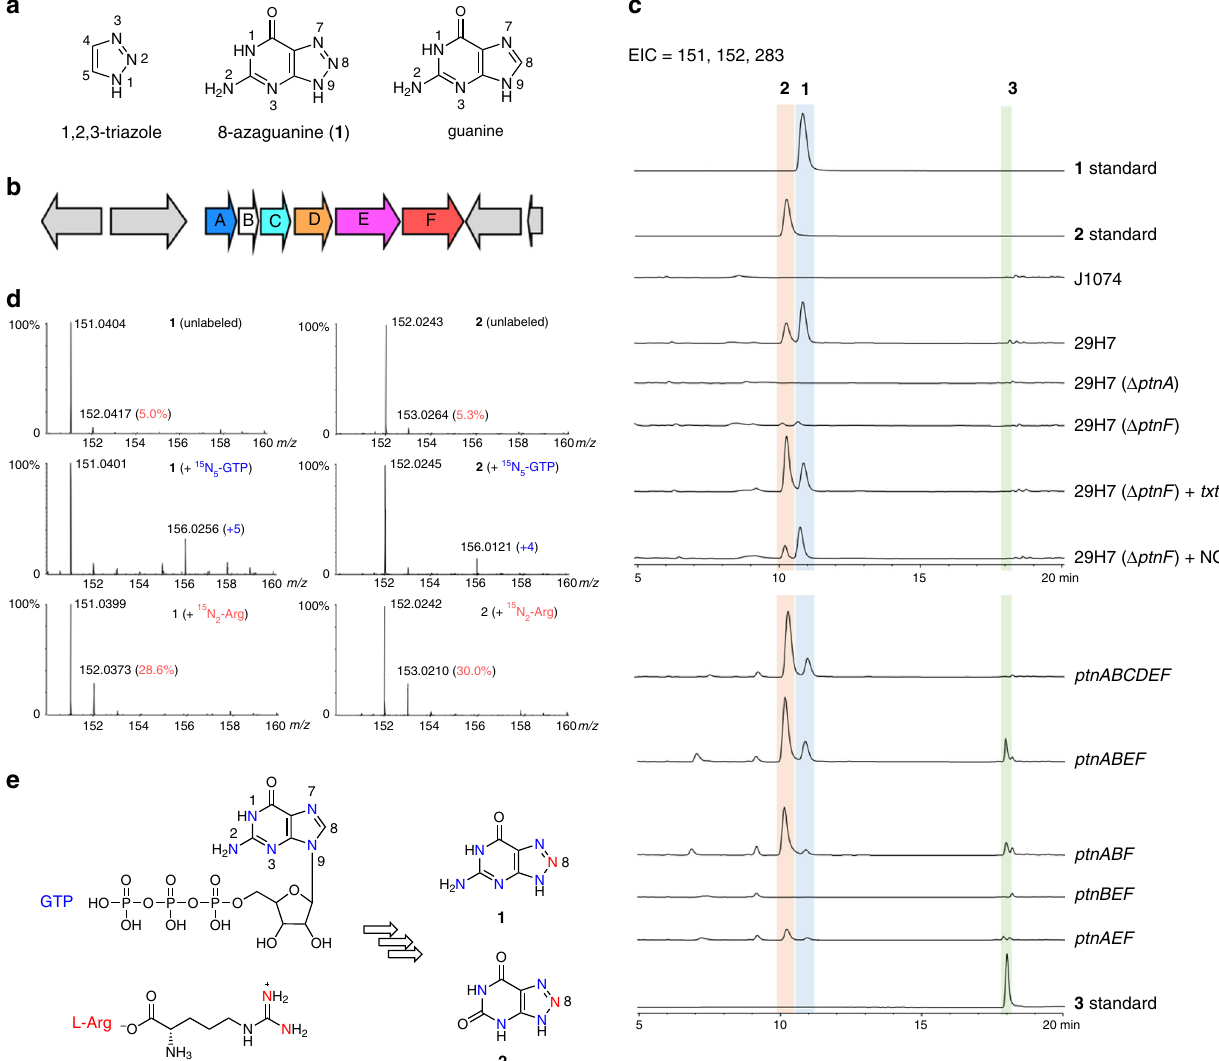
Fig. 1 Biosynthetic investigation of 8-azaguanine (1). a The structures of 1,2,3-triazole, 8-azaguanine ( 1 ) and guanine. b The biosynthetic gene cluster ( ptn cluster) of 8-azaguanine. c Heterologous expression and in vivo reconstitution of the 1 biosynthetic pathway in S. albus J1074. The extracted ion chromatograms (EIC) for 1 ( m / z 151, [M − H] − ), 2 ( m / z 152, [M − H] − ), 3 ( m / z 283, [M − H] − ) from LC-MS analysis were presented. Note: three independent tests were taken, the ratio of 1 to 2 varies from batches to batches, which could be attributed to the fl uctuation of host metabolism, as 2 derives from 1 by a host enzyme (guanine deaminase). d LC-HR-ESI-MS analysis of 8-azaguanine ( 1 ) and 8-azaxanthine ( 2 ) from stable isotope-labeled precursors feeding experiments. e Isotope-labeling pattern of 1 and 2 based on results from ( d